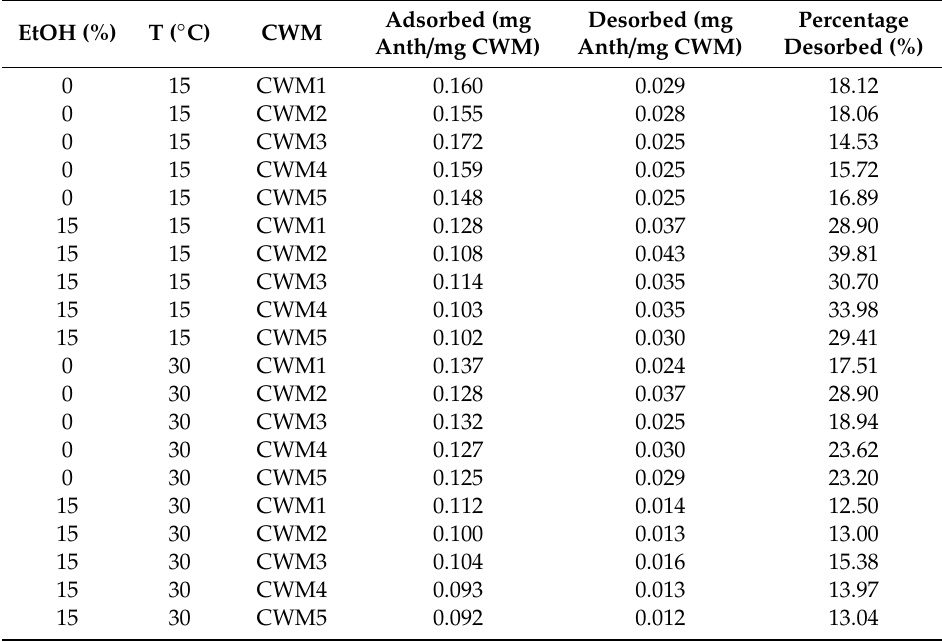
Figure 3. Desorption kinetics for CWM2 at all the experimental conditions ( n = 3). Error bars included. Table 3. Values of the mass adsorbed and desorbed for each of the conditions analyzed after 120 min ( n = 3). Percentage of desorption reached for each condition at 120 min. RSD < 5% for all the measurements